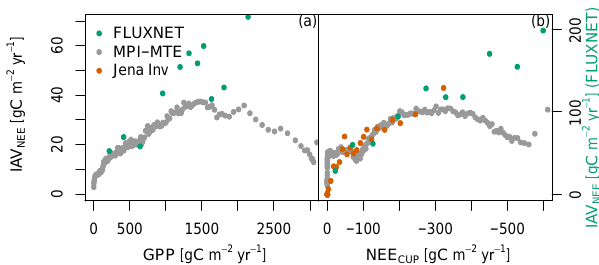
Figure 3. Dependency of NEE interannual variability on GPP and NEE CUP . Results are shown for FLUXNET sites (green dots, dif- ferent y scale on the right), for the MPI-MTE NEE (grey dots) and the Jena Inversion product (red